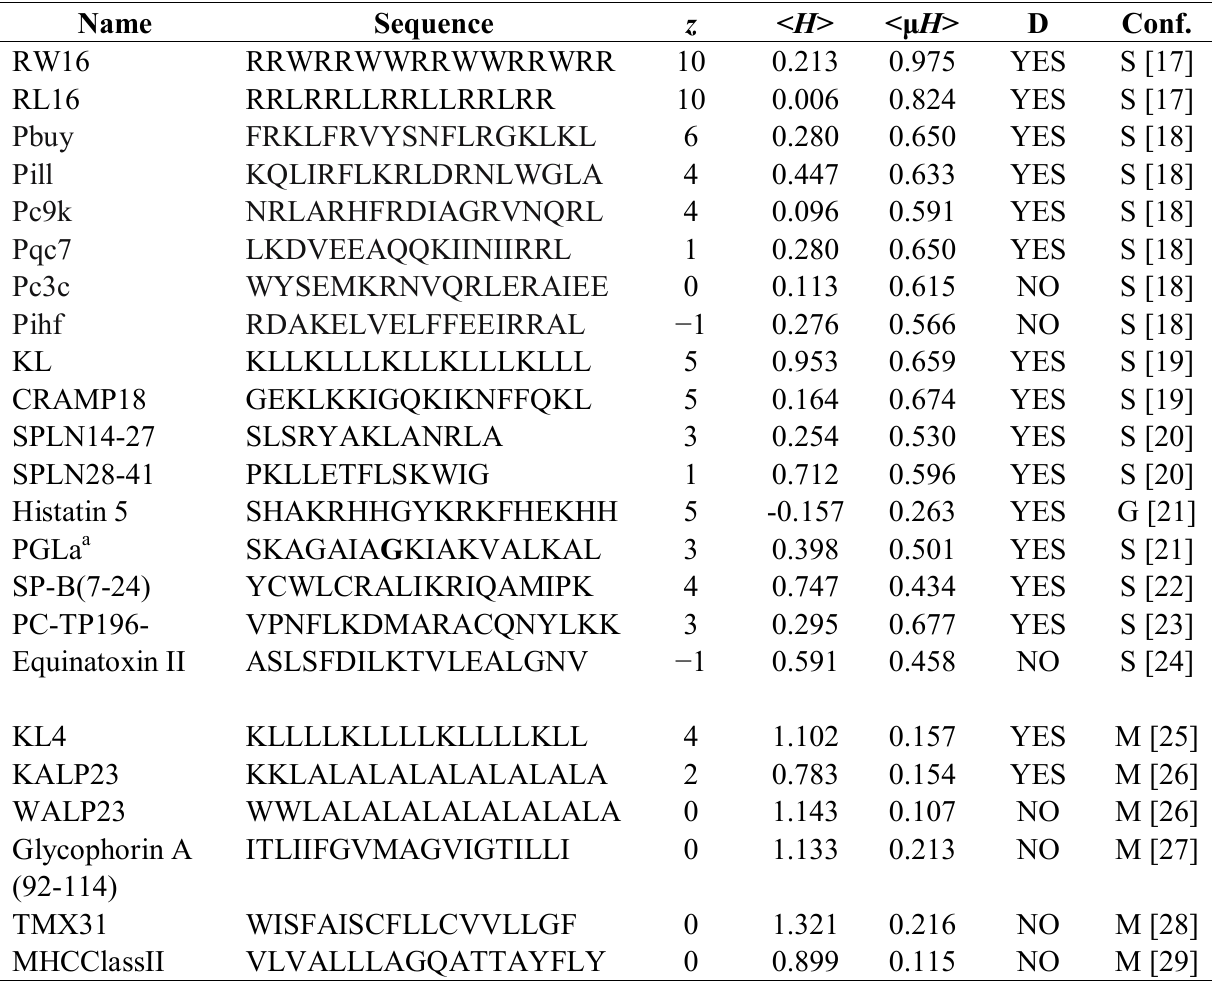
Table 1. Representative examples of clearly identified transmembrane (M) and surface seeking (S) regions of proteins and peptides as reported in the literature in the period